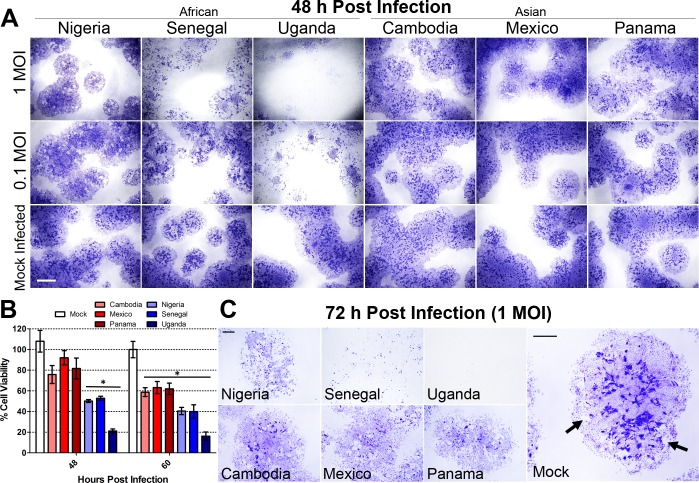
Cytopathic effects (CPE) caused by three AF and three AS ZIKV strains in ESCd at 48, 60 and 72 h PI.Colonies of ESC were grown in 6-well matrigel-coated cell culture dishes and differentiated for 4 days by BAP treatment. After 4 days, cells were infected with each ZIKV strain at 1, 0.1 or 0 (mock) MOI. (A) At 48 h PI, cells were fixed and stained with crystal violet to observe CPE. Cell lysis was evident in cells infected with all three of the AF strains, even at 0.1 MOI, whereas minimal cell lysis was evident in AS ZIKV infected (1 MOI) colonies. (B) Cell viability was measured at 48 h and 60 h PI to demonstrate the extent of lysis induced by each ZIKV strain at 1 MOI. At 48 h post- infection, only the three AF strains of ZIKV (shades of blue) showed a significant reduction in cell viability when compared to the mock infected control (one-way ANOVA, p < 0.001). Conversely, none of the AS strains of ZIKV (shades of red) induced a significant reduction in cell viability. All six ZIKV strains showed a significant reduction in cell viability when compared to the mock infected control at 60 h PI (p < 0.01 (Mexico), p < 0.001 (all other strains)). Data are presented as mean ± SEM (n = 5). (C) The extent of cell lysis at 72 h PI is accentuated by images taken at a higher magnification. At 72 h PI, severe cell lysis was evident in cells infected with all three AF strains and became apparent in cells infected with the AS strains. In the images, areas of deep purple staining highlight the areas of multinucleated syncytia. There were no syncytial areas present in the cultures infected with the AF strains of ZIKV, while small areas remained visible after infection with the AS strains. At 72 h PI, mock infected controls showed non-virus induced cell lysis, as the cells naturally started to die off at this time point post-differentiation. These areas are indicated by black arrows. Scale bars are 3 mm (A) and 1 mm (C).